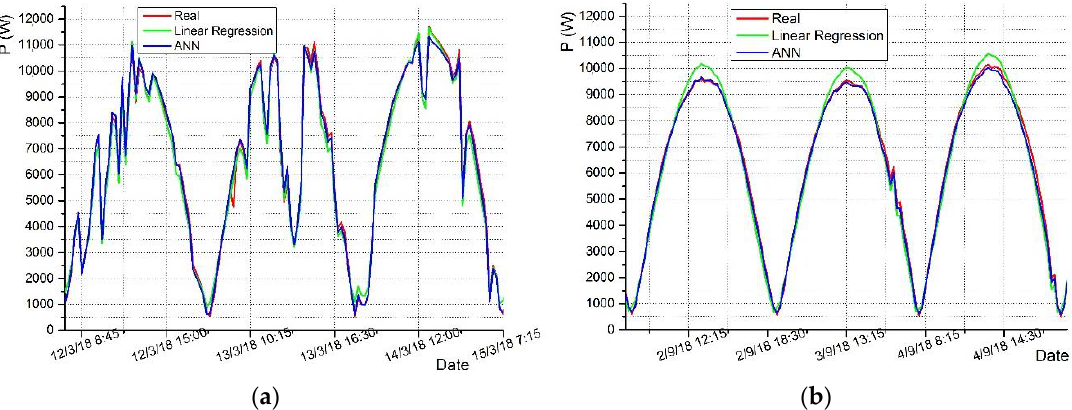
Figure 11. Comparison between real power output and two models forecasting for three cloudy ( a ) and three sunny days ( b ) for 2018.